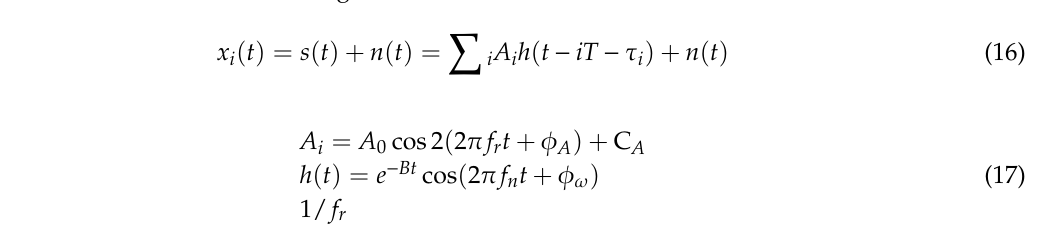
Table 1. The parameters of outer fault simulation signal.